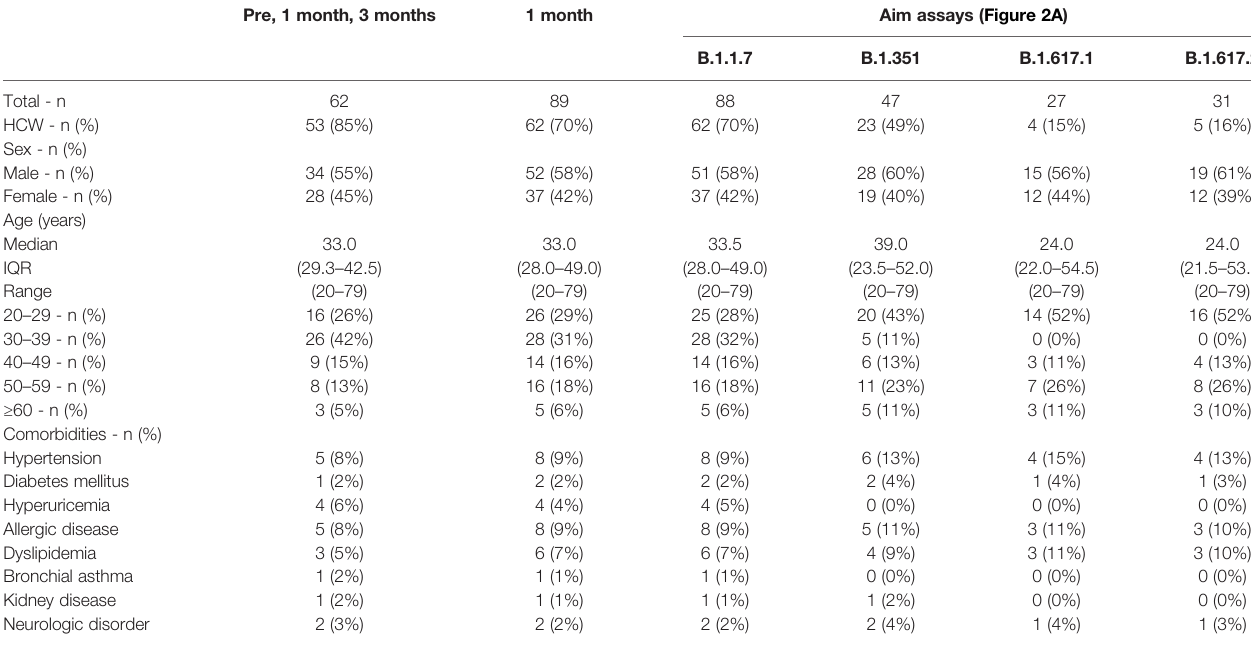
TABLE 1 | Characteristics of the study